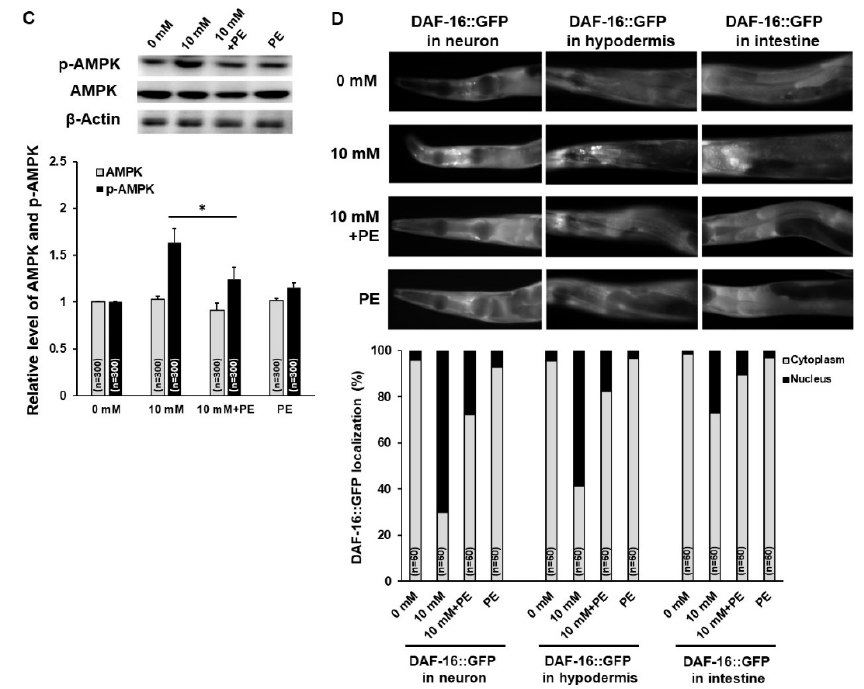
Figure 6. Phosphoethanolamine (PE) supplementation mitigates mitochondrial stress response and activation of AMPK and DAF-16 owing to ca ff eine intake in Caenorhabditis elegans . ( A , B ) HSP-6::GFP and GST-4::GFP transgenic animals were synchronized at the L4-stage and fed either 0 or 10 mM of ca ff eine for 24 h at 20 ◦ C with PE supplementation, and the respective fusion proteins were observed under fluorescence microscopy and quantified using ImageJ analysis. Statistical significance was calculated using one-way ANOVA. *, p < 0.05. Error bars represent standard deviation (SD). ( C ) Western blot analysis of phospho-AMPK protein levels in animals fed ca ff eine with PE supplementation. Respective AMPK and phospho-AMPK band intensities were normalized against those of β -Actin in the same lane. Then, the normalized AMPK and phospho-AMPK band intensities were converted to a relative value in comparison to that of the normalized AMPK and phospho-AMPK band intensities at 0 mM, as shown in the graph; values are mean ± SD of three biological replicates of lysates from 300 animals. Statistical significance was calculated using the Student’s t -test. *, p < 0.05. ( D ) Images show the DAF-16::GFP expression patterns of animals fed ca ff eine supplemented with PE in the respective tissues. DAF-16::GFP transgenic animals were synchronized at the L4-stage and were fed either 0 or 10 mM of ca ff eine for 24 h at 20 ◦ C with PE supplementation, and the fusion protein was observed under fluorescence microscopy. The graph indicates the percentage of animals that show a distribution in the subcellular localization of DAF-16 in the respective tissues.